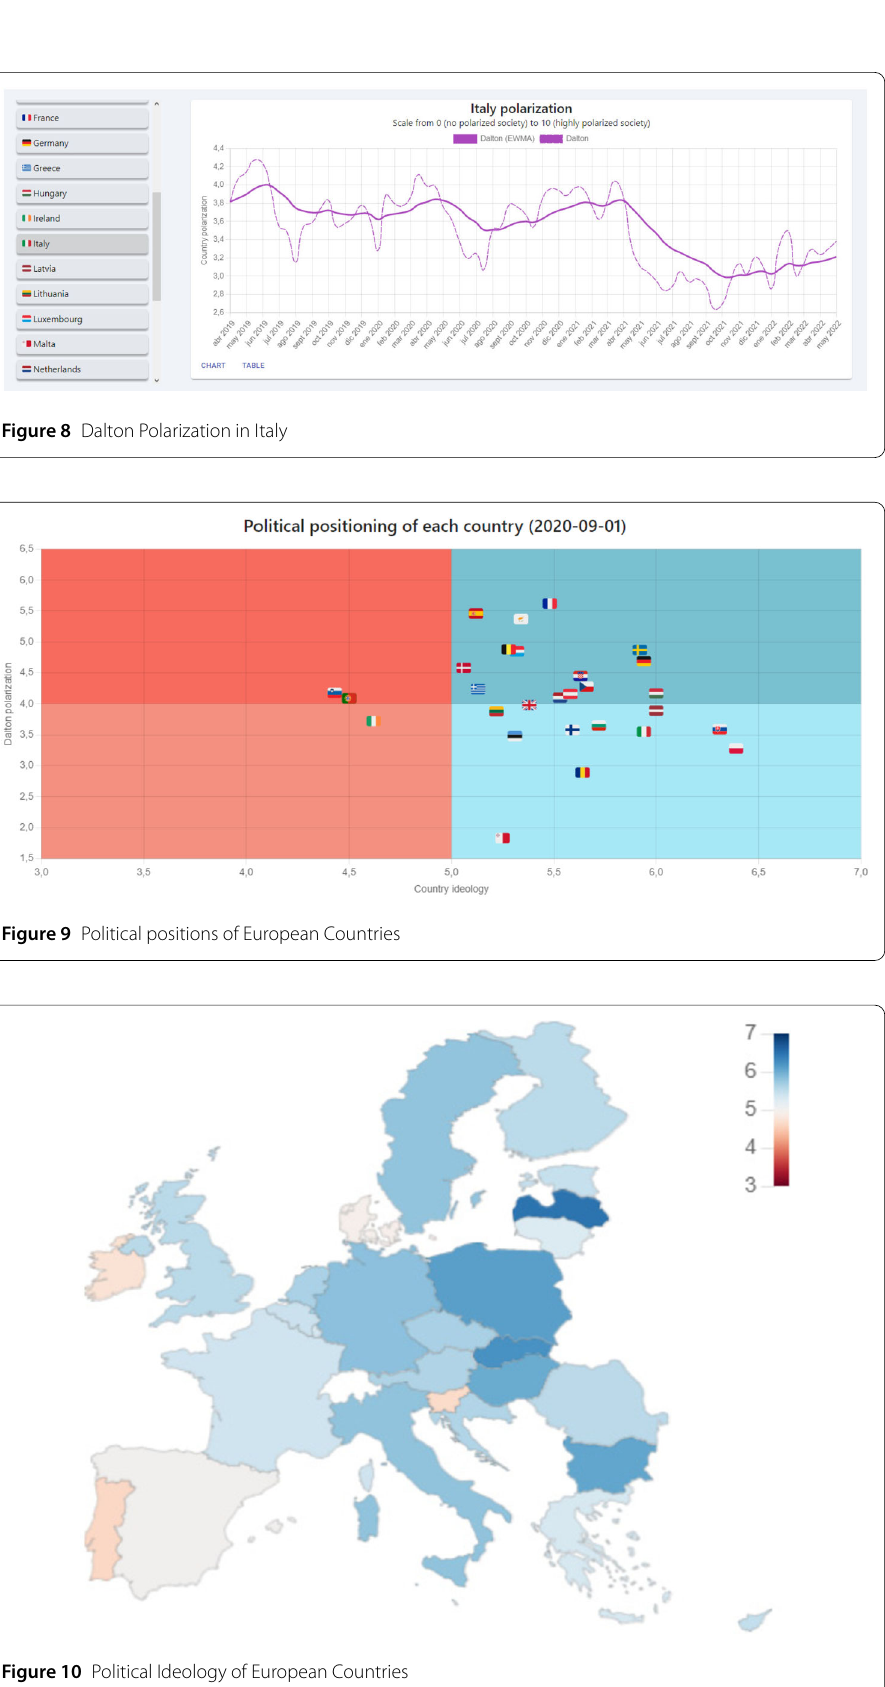
Figure 10 Political Ideology of European